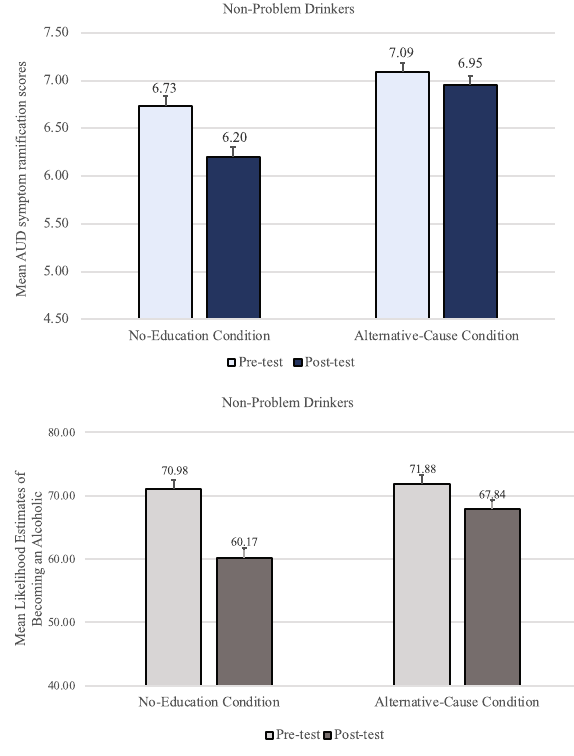
Figure 4. Non-problem-drinkers’ mean AUD symptom ramification scores and mean likelihood estimates of becoming an alcoholic in Study 2, by condition at pre-test and post-test. Error bars represent SEM pairedDiff